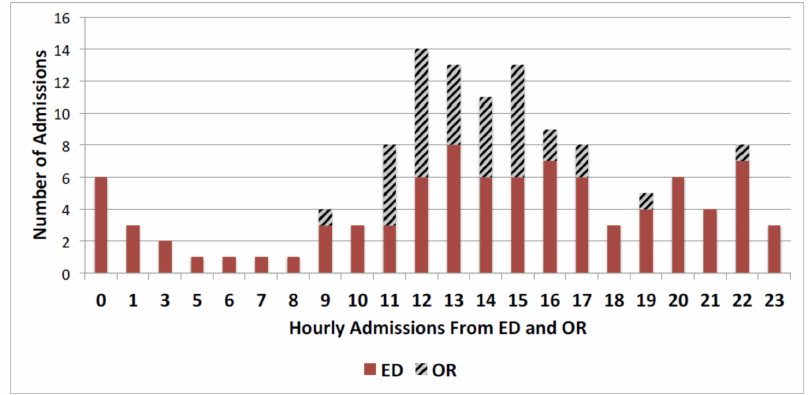
Figure 4. One month’s total hourly inpatient bed requests from ED and OR.